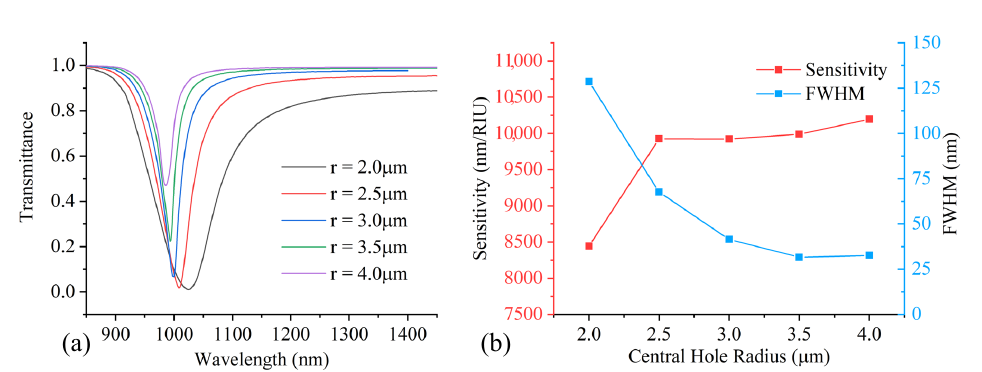
Figure 8. ( a ) The resonance spectra of the proposed sensor with di ff erent central hole radii r . ( b ) The full-width at half-maximum (FWHM) and sensitivity of the sensor under di ff erent values of r . The figure of merit (FOM) values along with the increases of r : 65.6, 146.9, 239.1, 315.7, and